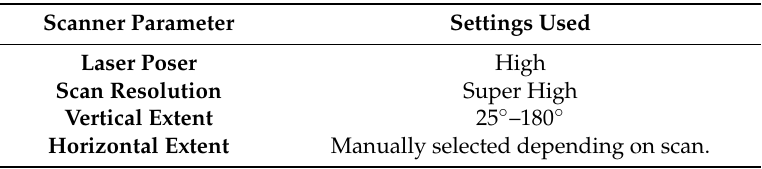
Manually selected depending on scan.